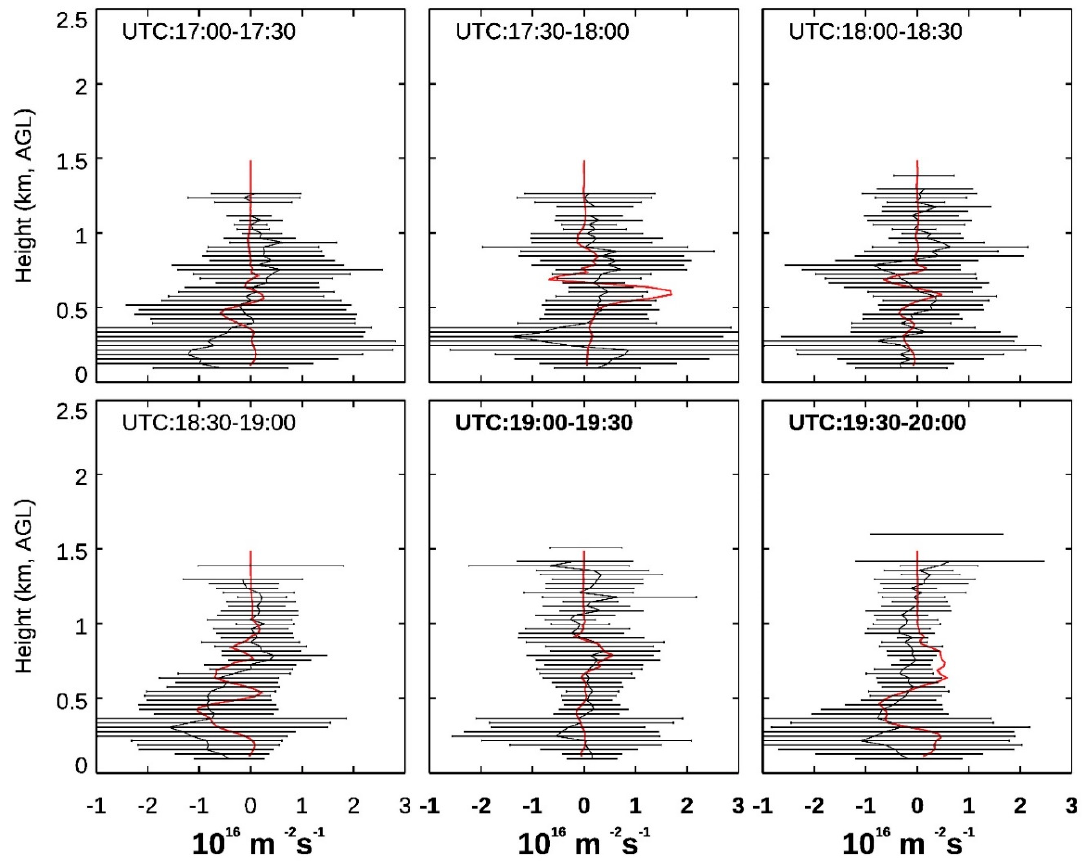
Figure 8. The solid black lines represent the observed ozone turbulence flux with statistical errors at each level, shown in horizontal black lines. The solid red line represents the simulated ozone turbulence flux with standard NO emission at six corresponding intervals. The ozone flux is calculated as ozone number density times velocity, as in Equation (5).